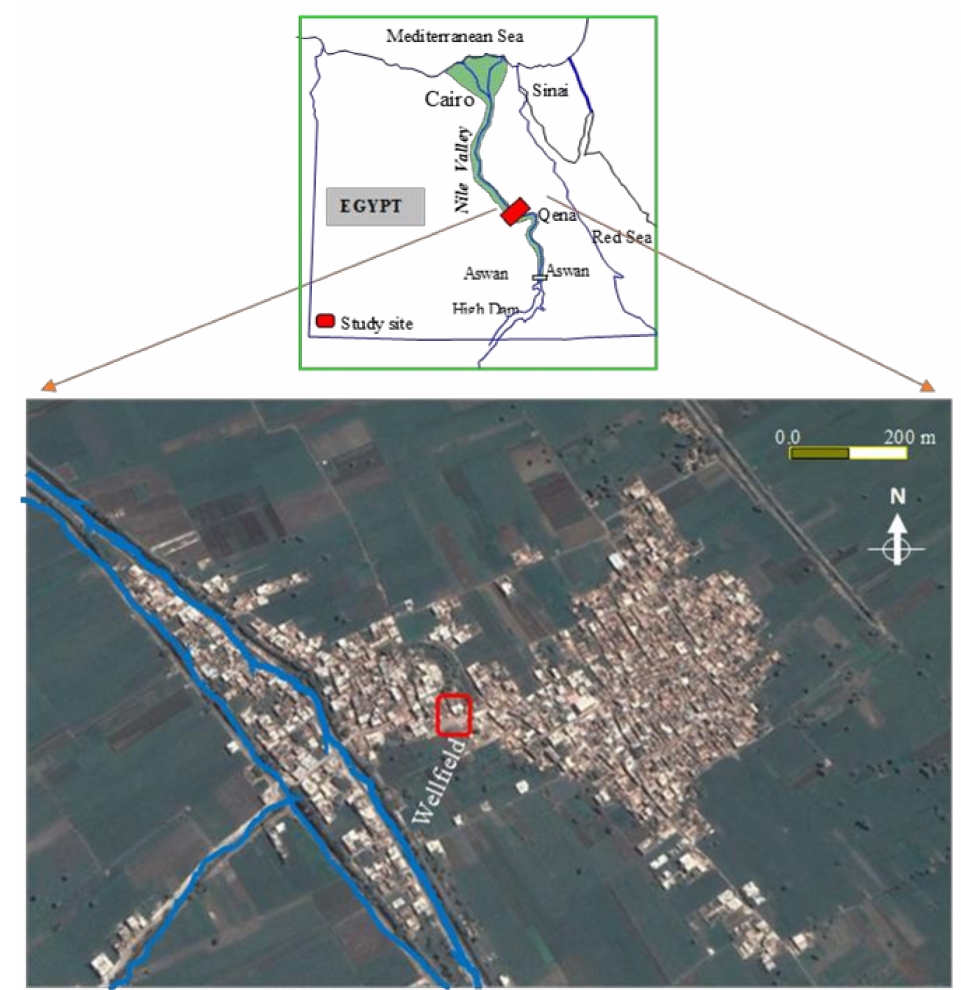
Figure 2. Location of the investigated wellfield and the village buildings with two